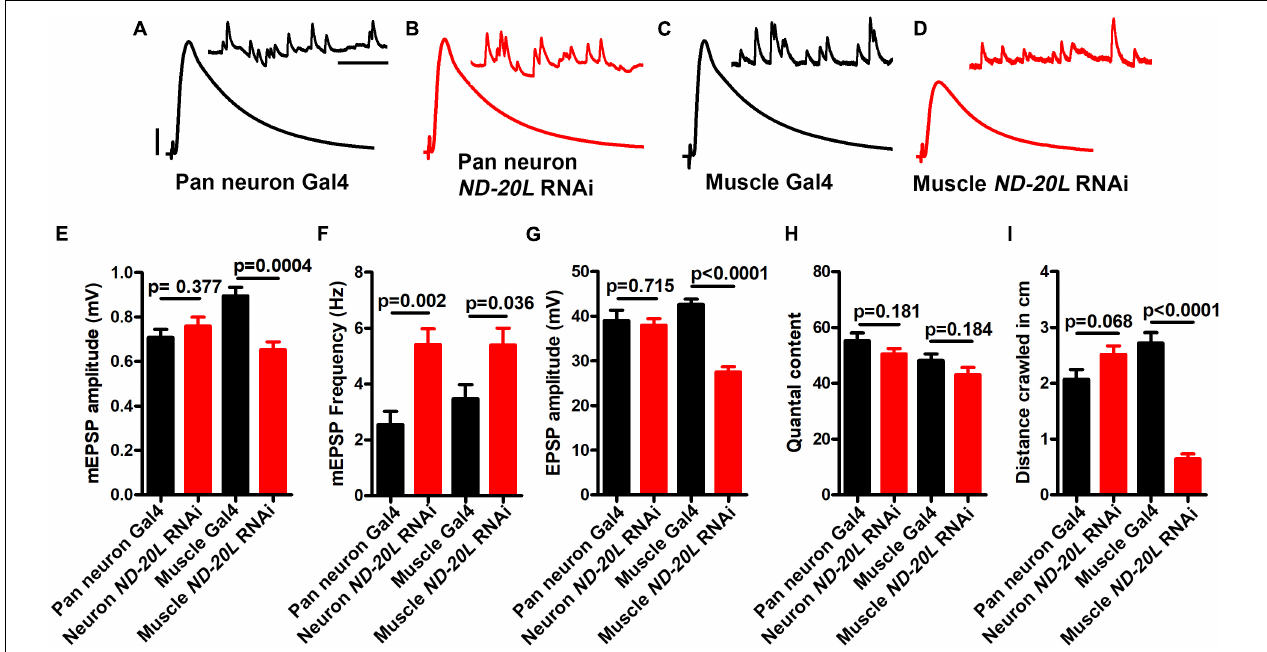
FIGURE 4 | Muscle-specific knockdown of ND-20L[RNAi] affects neurotransmission and motor behavior in Drosophila . (A–D) Representative traces of mEPSPs and EPSPs in (A,B) pan-neuronal elaV(C155)-Gal4/ +, pan-neuronal elaV(C155) - Gal4 driven ND-20L[RNAi] , { elaV(C155)/ + ; ND-20L[RNAi]/ +} and (C,D) BG-57-Gal4/ +, BG-57-Gal4 driven ND-20L[RNAi] , ( BG-57-Gal4/ + ; ND-20L[RNAi]/ +) animals. Scale bars for EPSPs (mEPSPs) are x = 50 ms (1000 ms) and y = 10 mV (1 mV). The knockdown experiments and electrophysiology recordings were performed at 25 ◦ C. Note that EPSPs amplitudes were reduced in muscle depleted ND-20L[RNAi] while pan-neuronal depleted ND-20L larvae did not show any remarkable change in EPSPs. (E–H) Histograms showing average mEPSPs amplitude, mEPSP frequency, EPSPs amplitude and quantal content are indicated in the Supplementary Table 3 . At least 6 NMJs recordings of each genotype were used for quantification. (I) Histogram showing crawling behavior (in cm) of the larvae in the indicated genotypes. Knocking down ND-20L[RNAi] in muscle showed a severe defect in crawling behavior. However, neuronally depleting ND-20L did not show any significant crawling defects. At least 10 animals were analyzed for crawling behavioral analysis. p-values are indicated in the figure. Statistical analysis based on Student’s t -test for pairwise comparison. Error bars represent mean ±